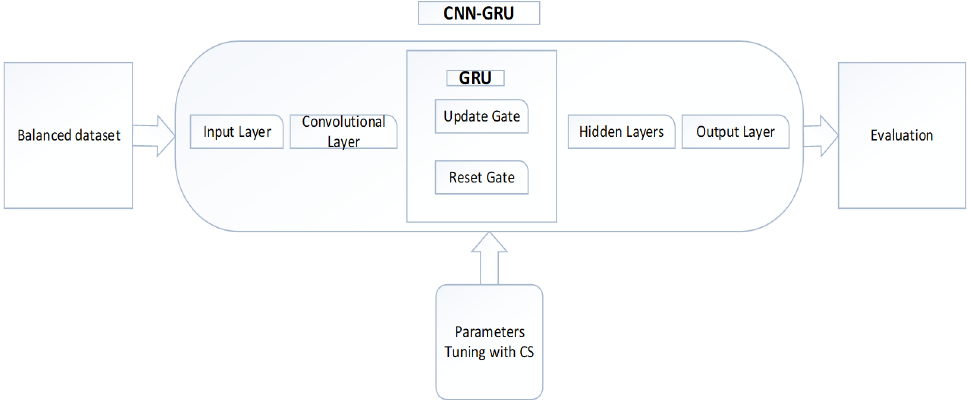
Figure 5. CNN-GRU-CS classification